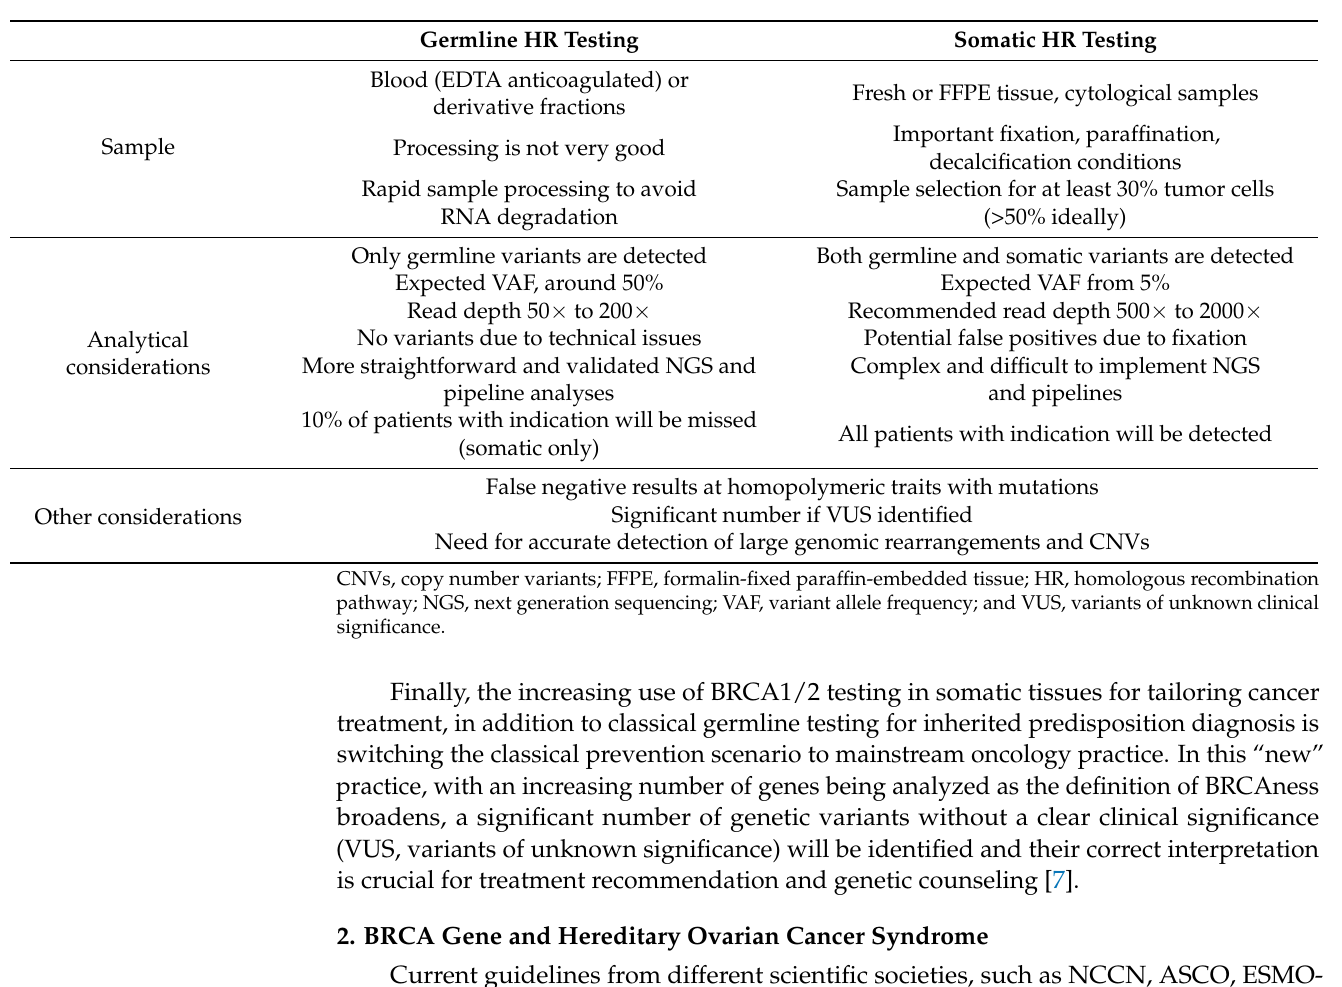
Table 1. Technical considerations for the somatic and germline analysis of HR